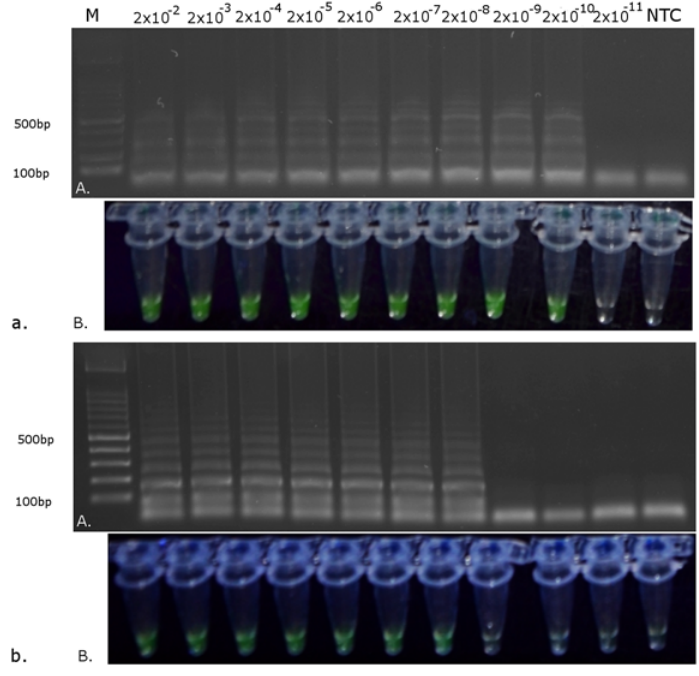
Fig 5. Visualization of LAMP reaction results with different dilutions of DNA template. A) After electrophoresis in a 1% agarose gel; B) using EvaGreen stain (Biotium). a) DNA extracted from one larva; b) DNA extracted from one adult specimen. NTC — no template control.